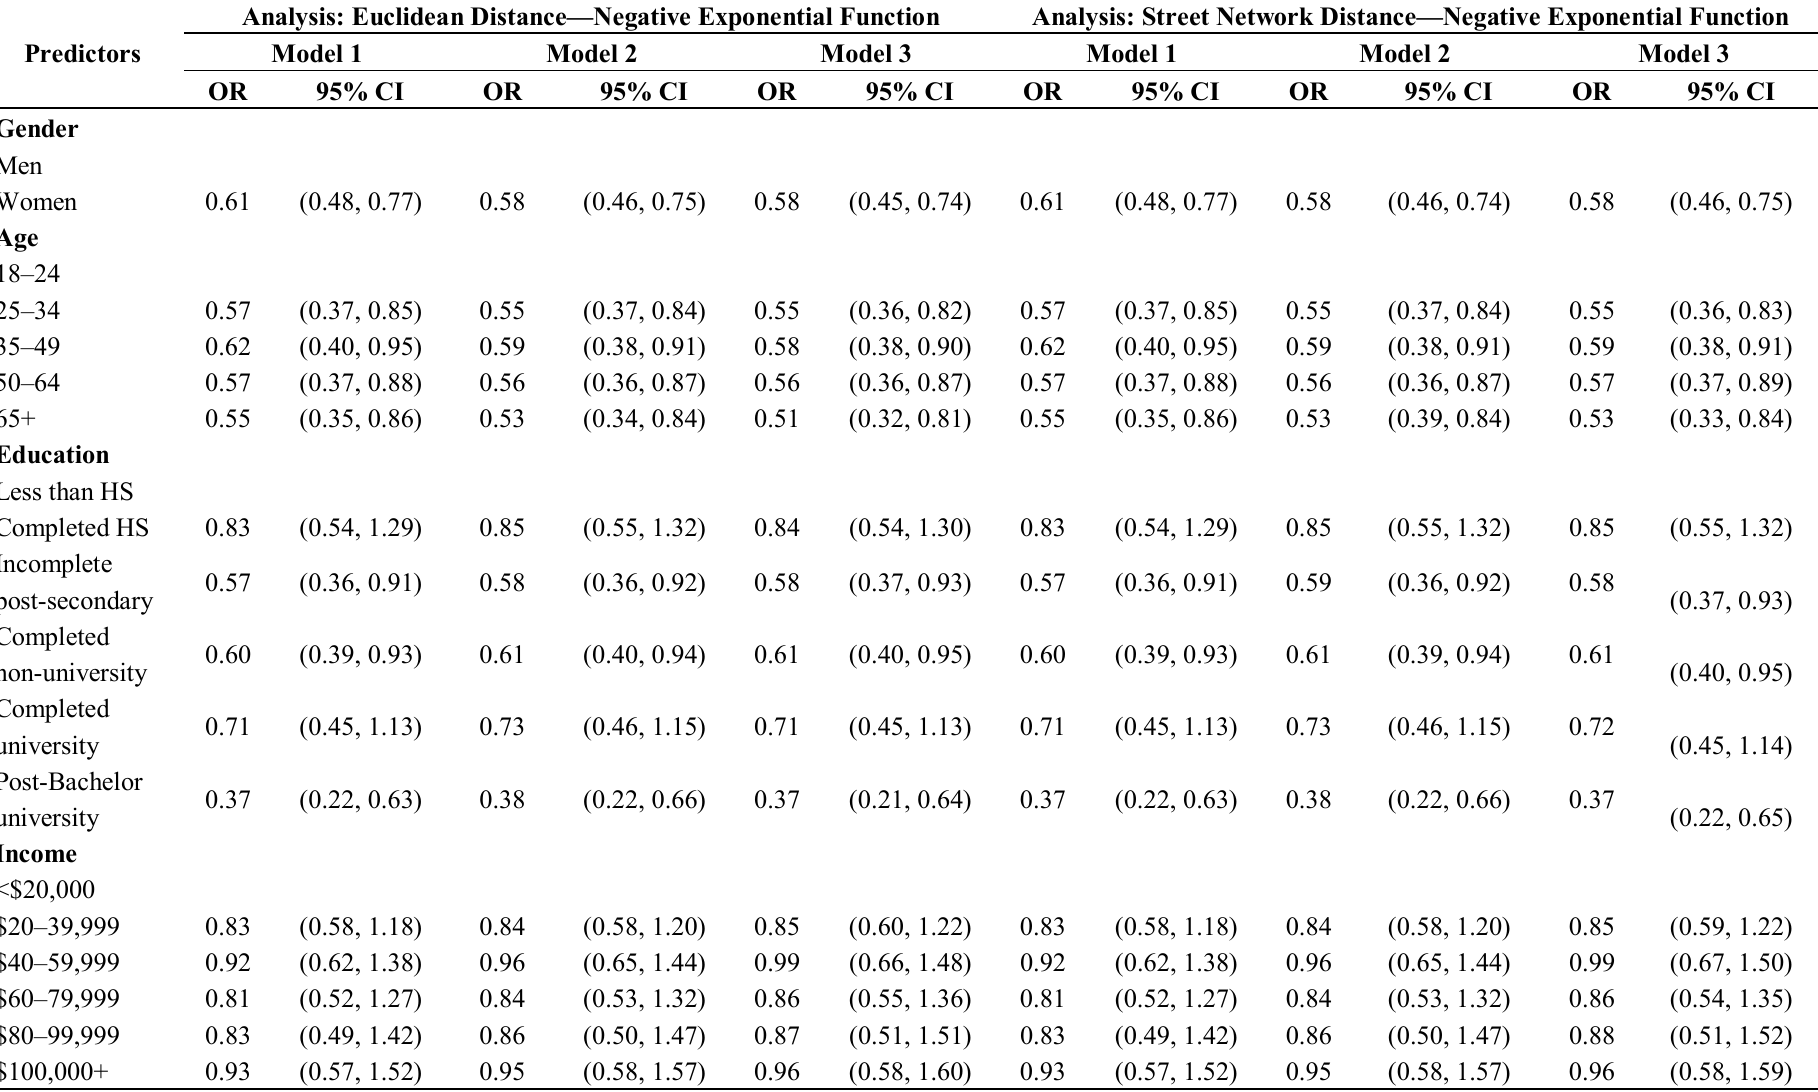
Table 3. Contribution of predictors to explaining self-reported levels of physical